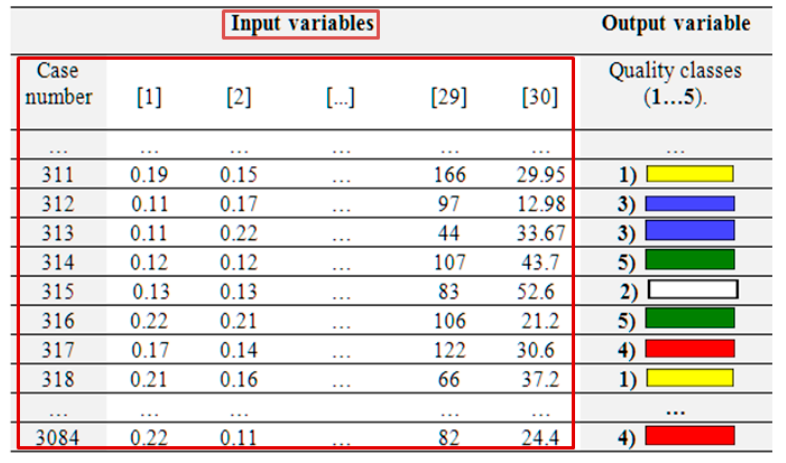
Figure 3. Quality conditions of the compost.